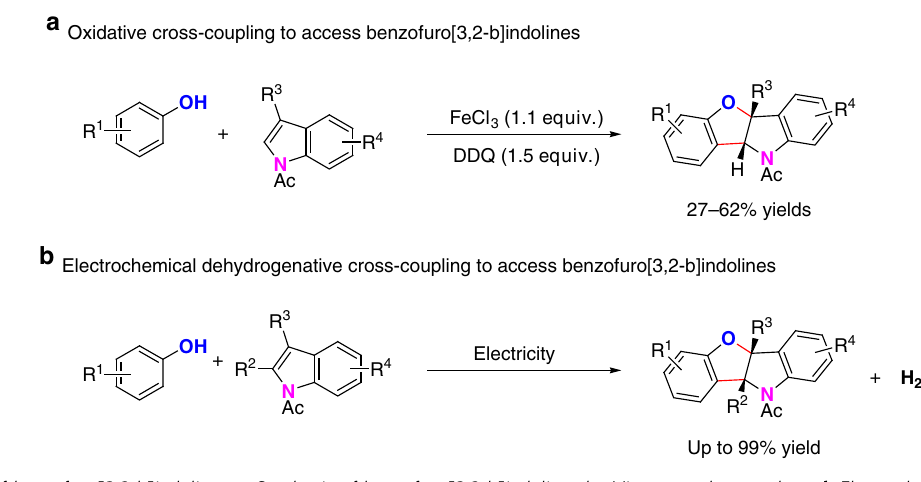
Fig. 1 Synthesis of benzofuro[3,2-b]indolines. a Synthesis of benzofuro[3,2-b]indolines by Vincent and co-workers. b Electrochemical synthesis of benzofuro[3,2-b]indolines under external oxidant-free conditions